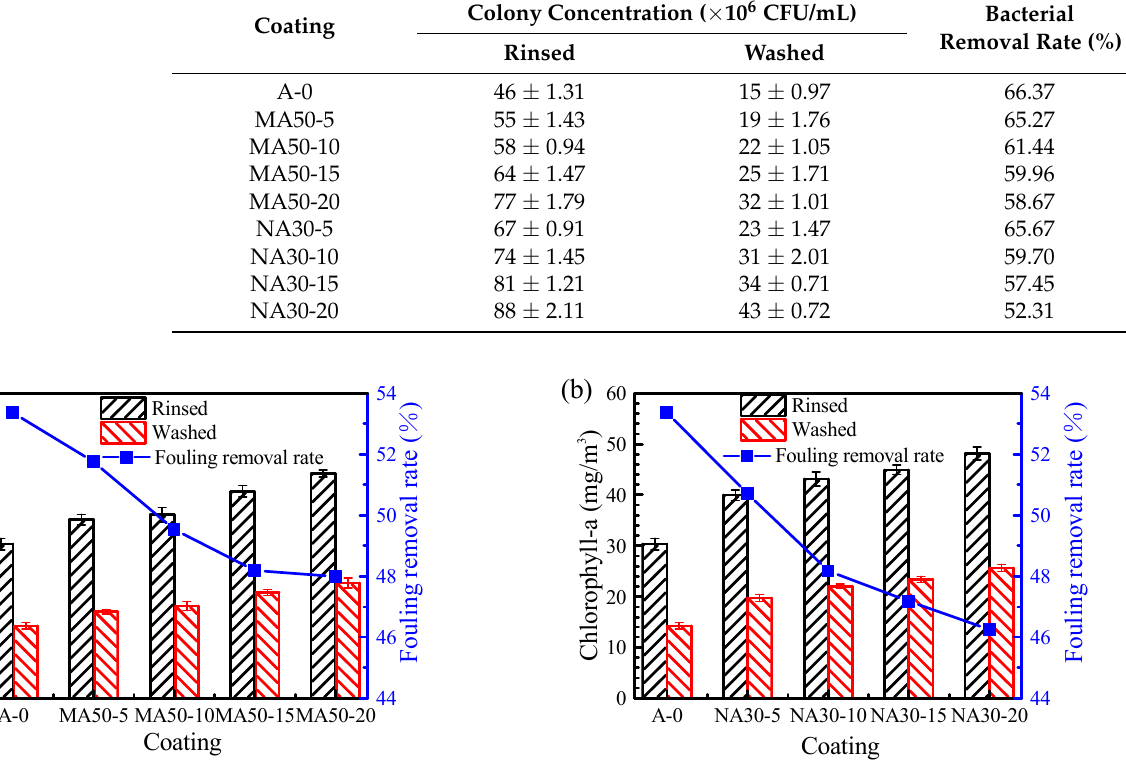
Figure 9. Effect of addition amount of alumina on the adhesion properties of Navicula Tenera : ( a ) Micro-alumina, ( b ) Nano- alumina.